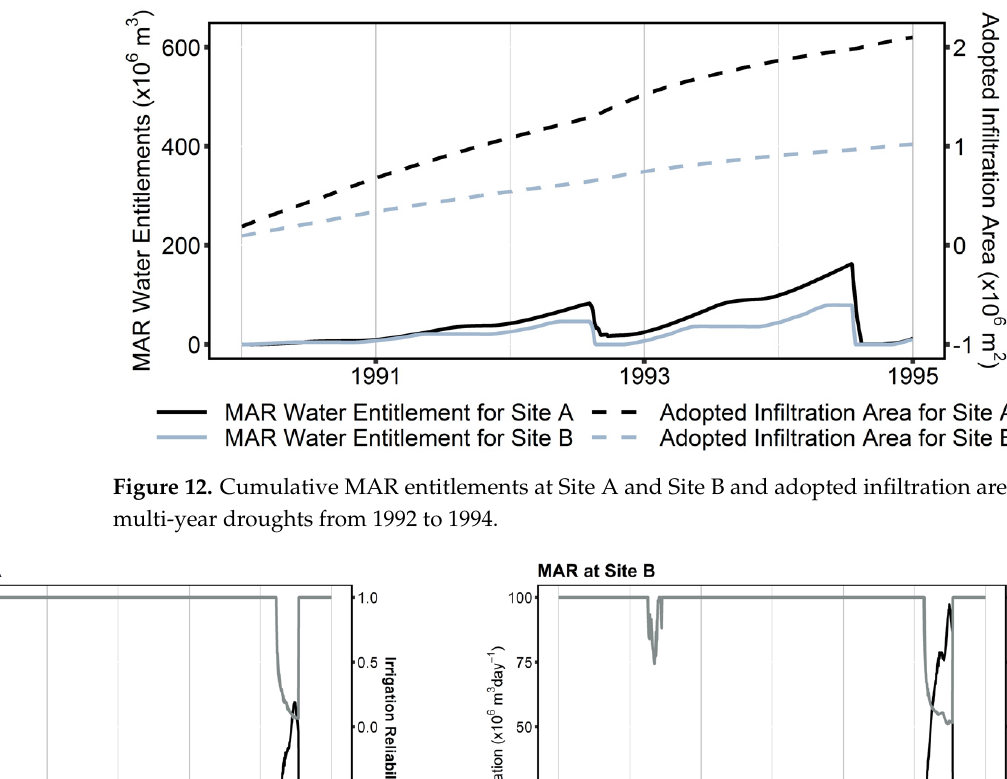
Figure 12. Cumulative MAR entitlements at Site A and Site B and adopted infiltration area during multi-year droughts from 1992 to 1994.